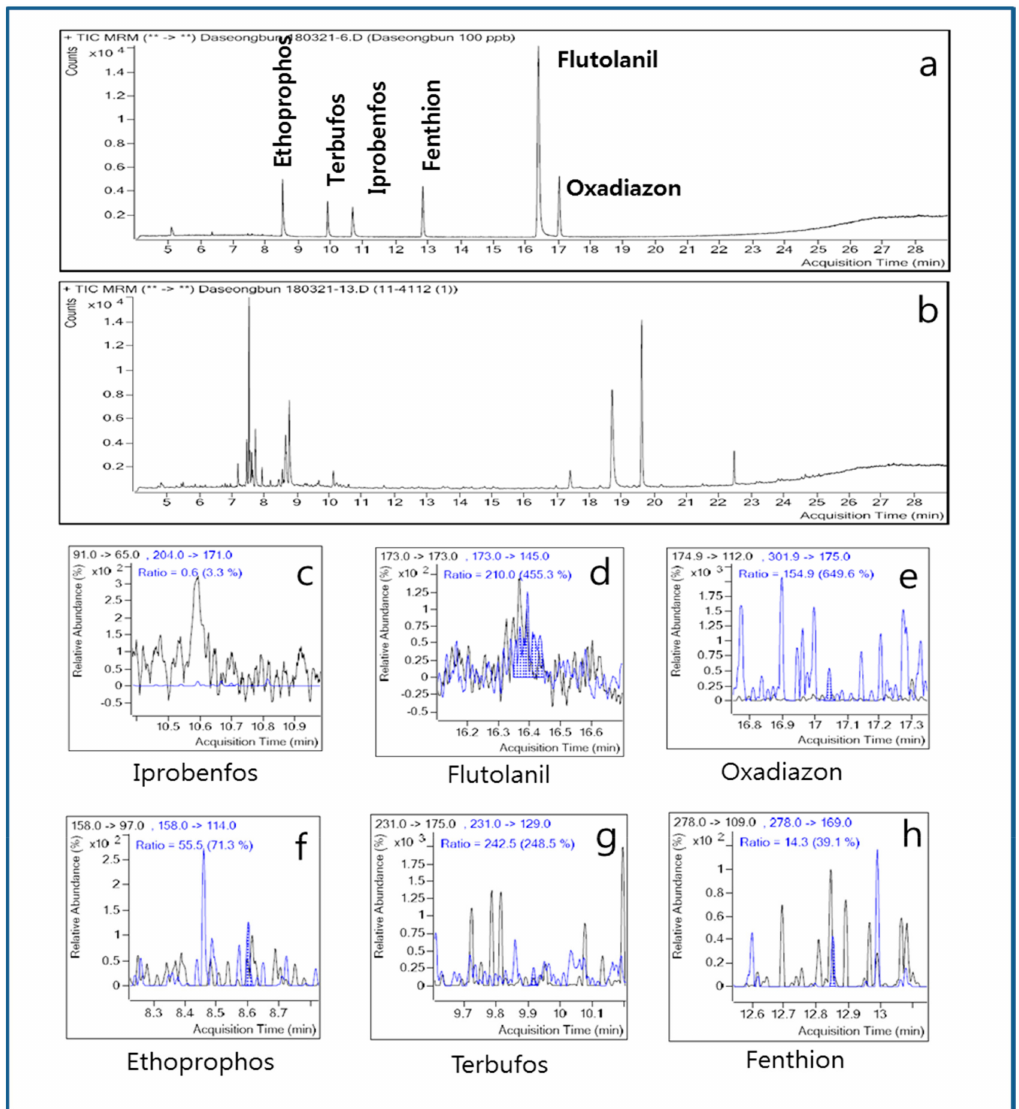
Figure 4. Identification of contaminating pesticides in the distilled spirits obtained from the pilot-plant scale distillation column. ( a ) Standards; ( b ) distilled spirits; ( c ) iprobenfos; ( d ) flutolanil; ( e ) oxadiazon; ( f ) ethoprophos; ( g ) terbufos; ( h )